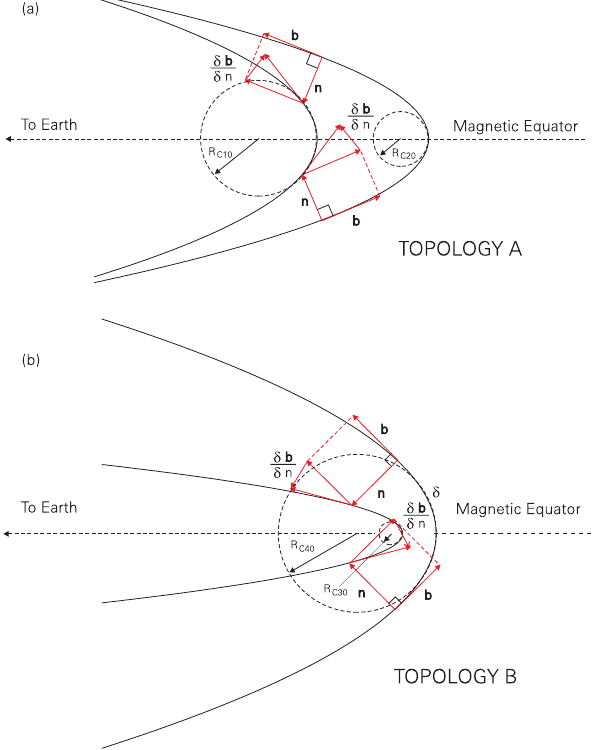
Fig. 1. Magnetic field configurations A and B. R c 10 , R c 20 , R c 30 , R c 40 are the equatorial curvature radii of the magnetic field lines. R c 10 > R c 20 and R c 30 < R c 40 . The direction of the vector ∂ b